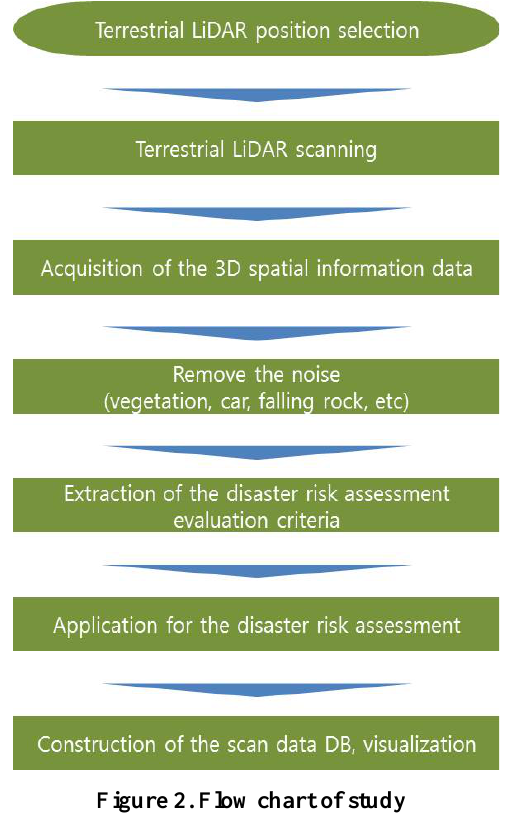
Figure 2. Flow chart of study